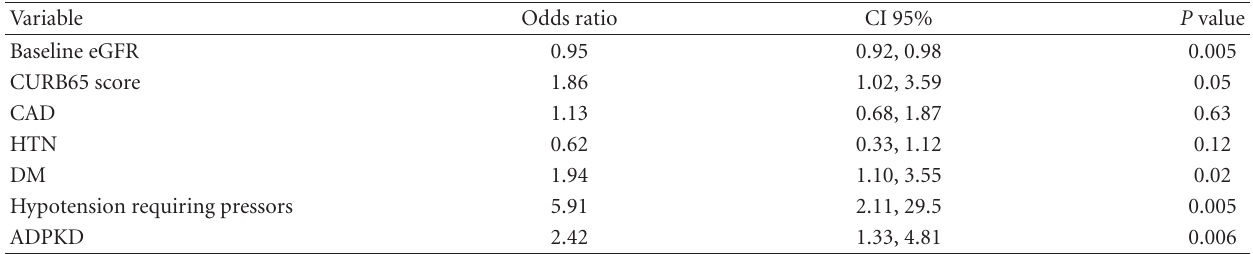
Table 4: Multivariate analysis for AKI risk factors in the entire cohort ( N = 115).